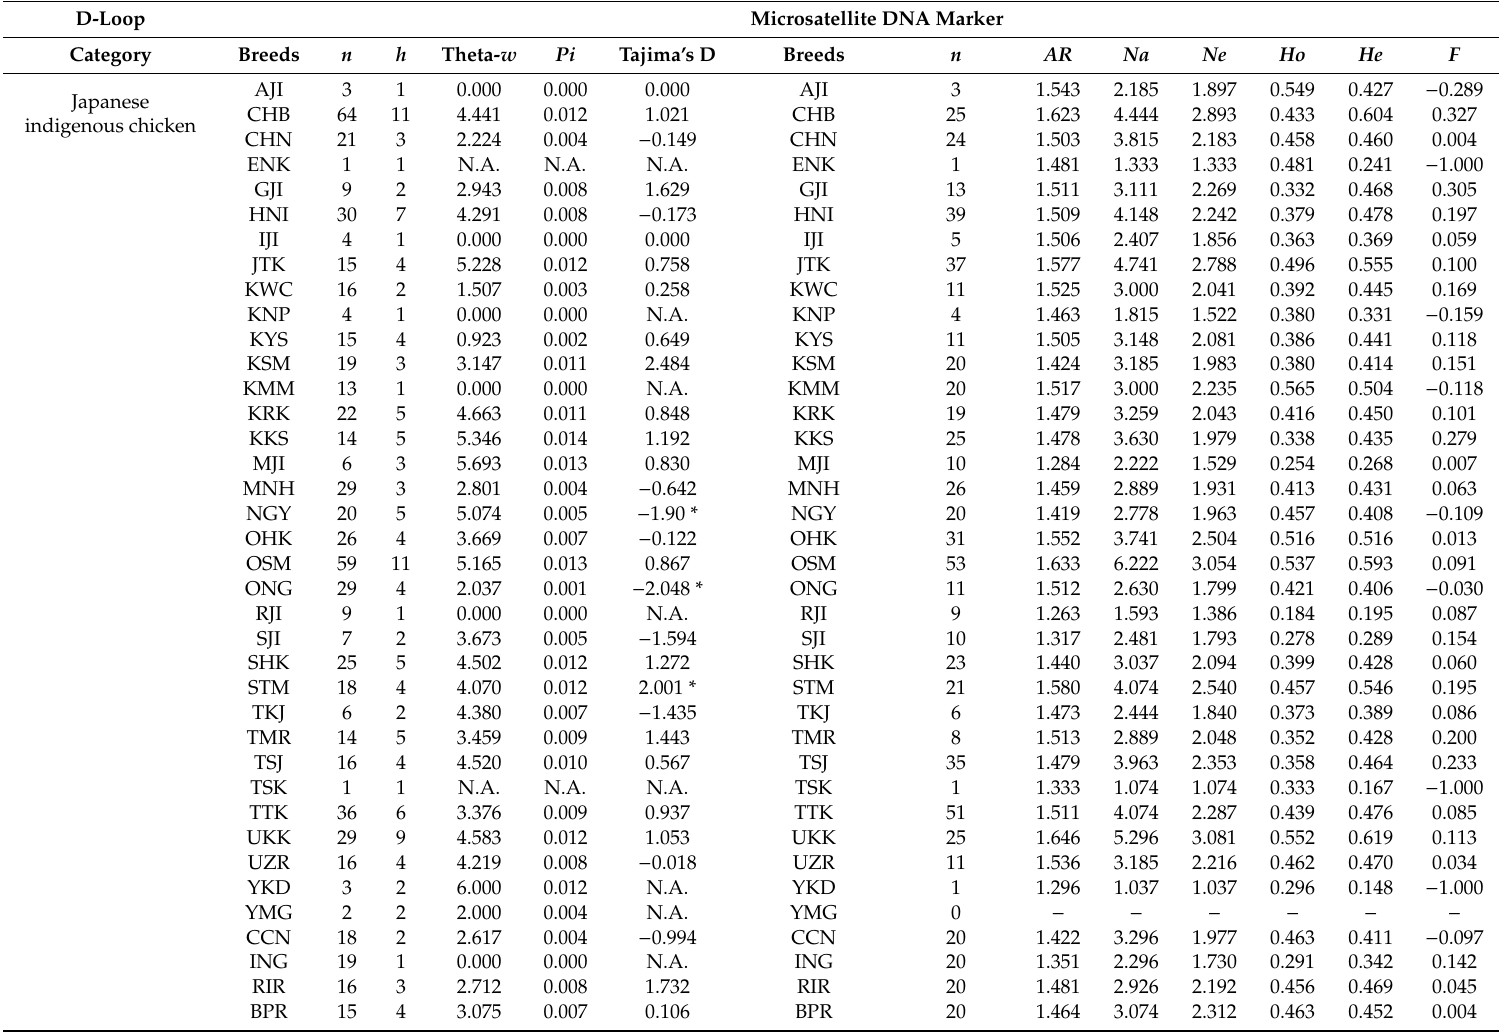
Table 3. Genetic Diversity indices of Japanese indigenous chickens and indigenous chickens